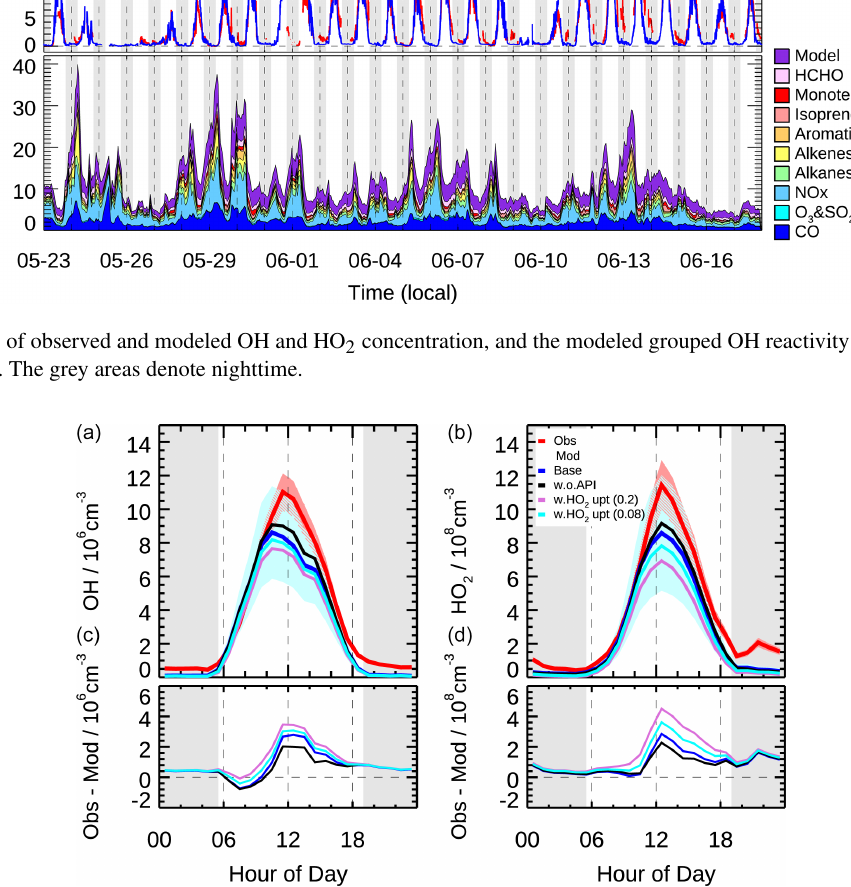
Figure 4. The mean diurnal profiles of measured and modeled OH and HO 2 concentrations (a) as well as the discrepancies between observation and model (b) in different scenarios (Scenario 1: base case; Scenario 2: without α -pinene constrained; Scenario 3: with HO 2 heterogeneous uptake process considered by assuming the uptake coefficient of 0.2; Scenario 4: with HO 2 heterogeneous uptake process considered by assuming the uptake coefficient of 0.08). Colored areas denote 1 σ uncertainties of measured (red) and base case modeled (blue) radical concentrations, respectively. The grey areas denote